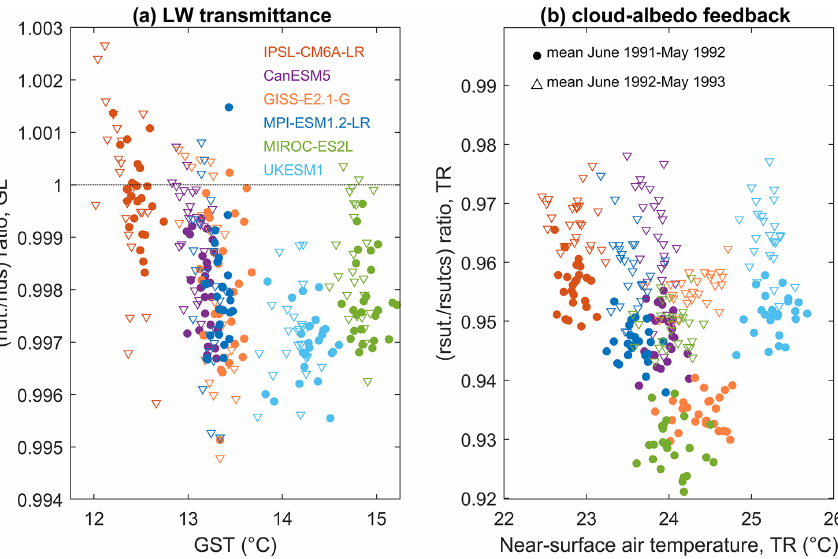
Figure 10. Response of the atmospheric LW transmittance and of the cloud–albedo feedback. (a) Scatterplot of the ratio of the global-average LWt/LWs ↑ (or rlut/rlus) calculated for the volc-pinatubo-full simulations over the corresponding piControl sections versus the post-eruption global-mean surface temperature (GST). (b) Scatterplot of the ratio of SWt / SWtcs for the tropical region (rsut/rsutcs) calculated for the volc-pinatubo-full simulations over the corresponding piControl sections versus the tropical-mean surface temperature. Analysis is based on averages for the periods from June 1991 to May 1992 (filled circles) and from June 1992 to May 1993 (empty